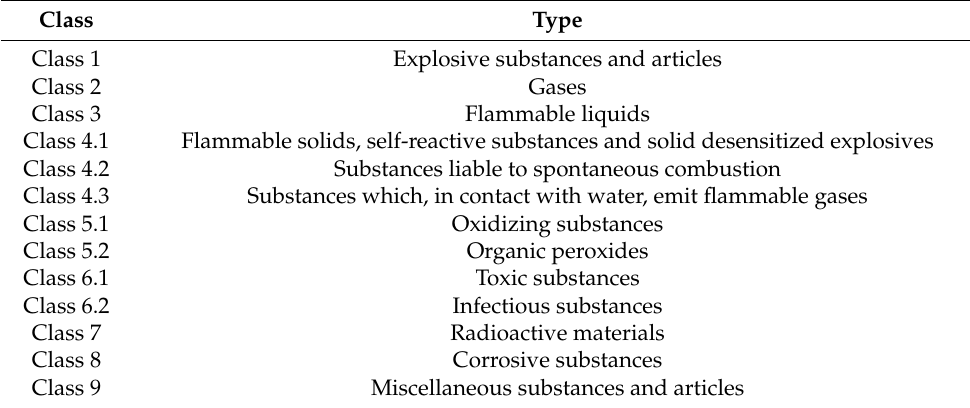
Table 3. Classification of ADR dangerous